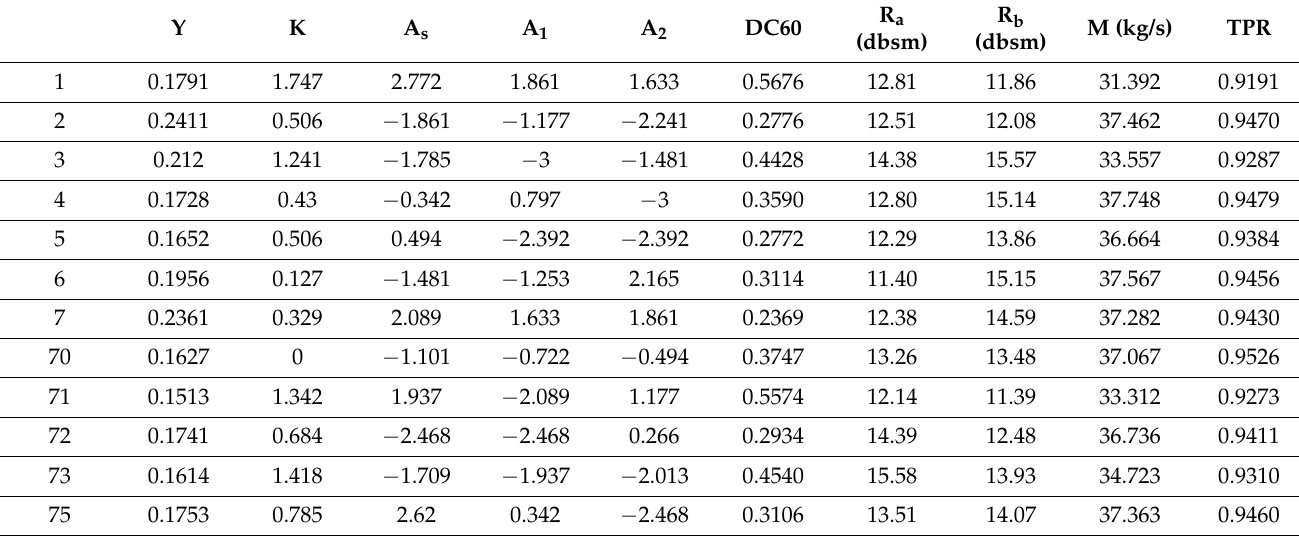
Table 8. Sample points and calculation